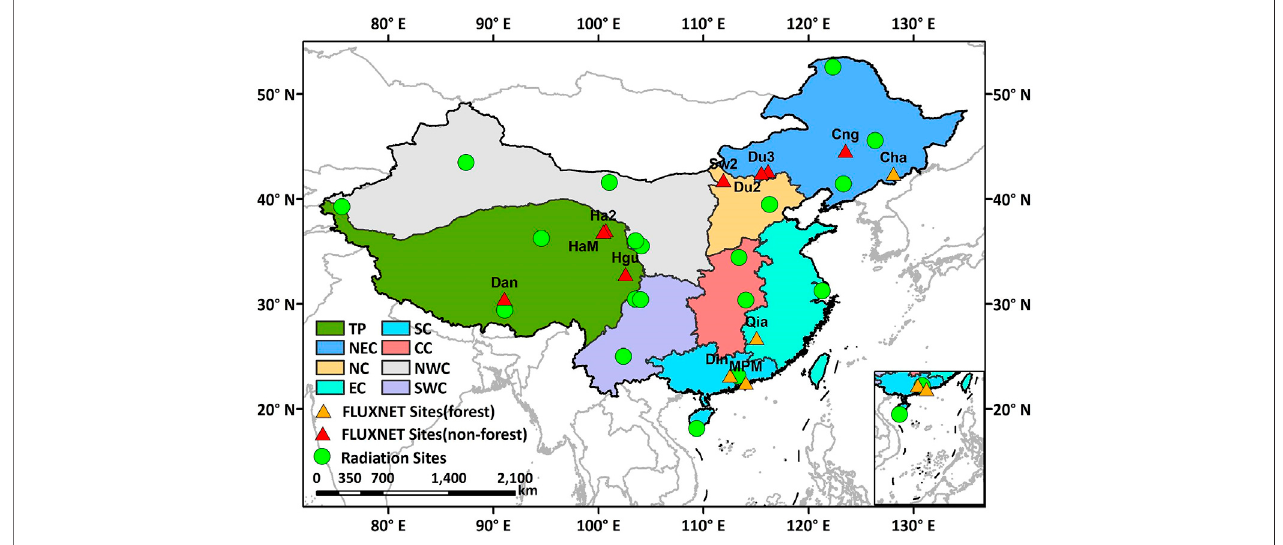
FIGURE 1 | The spatial distribution of the CMA radiation sites and FLUXNET sites. TP, NEC, NC, EC, SC, CC, NWC and SWC represent the Tibetan Plateau and northeastern, northern, eastern, southern, central, northwestern and southwestern China, respectively.